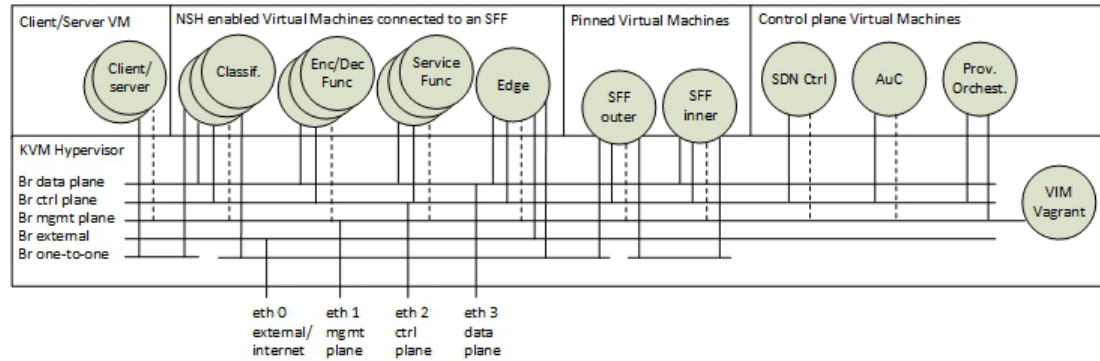
Figure 7. Virtual Machines and networks per Compute